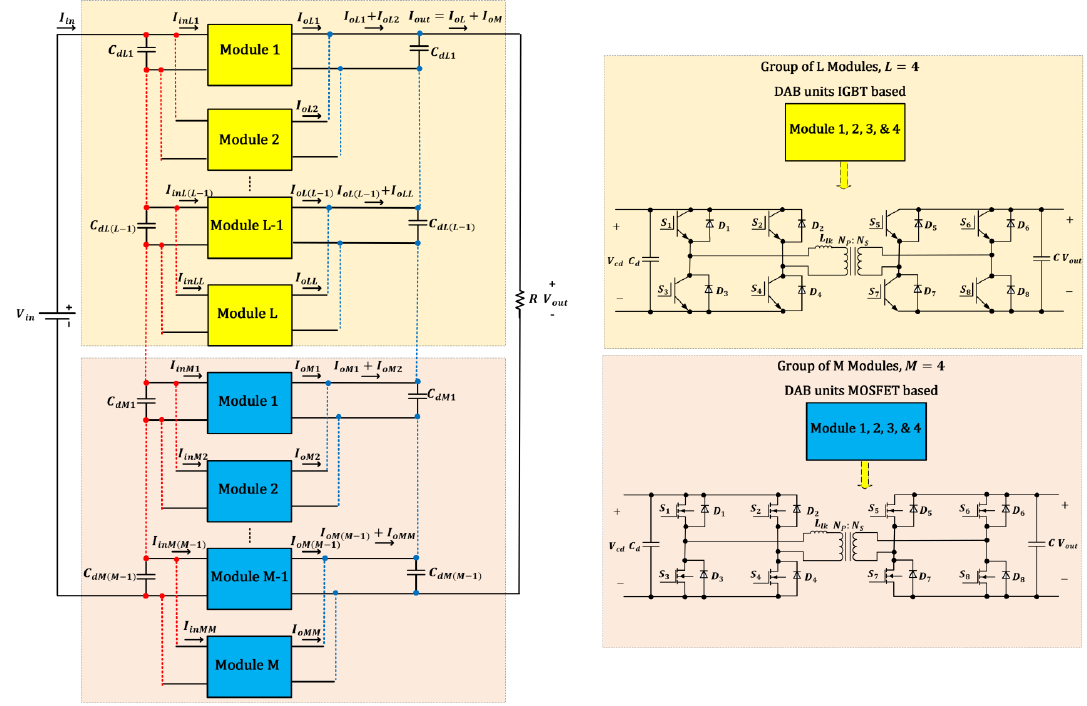
Figure 3. Generalized hybrid multimodule DC-DC converter configuration.